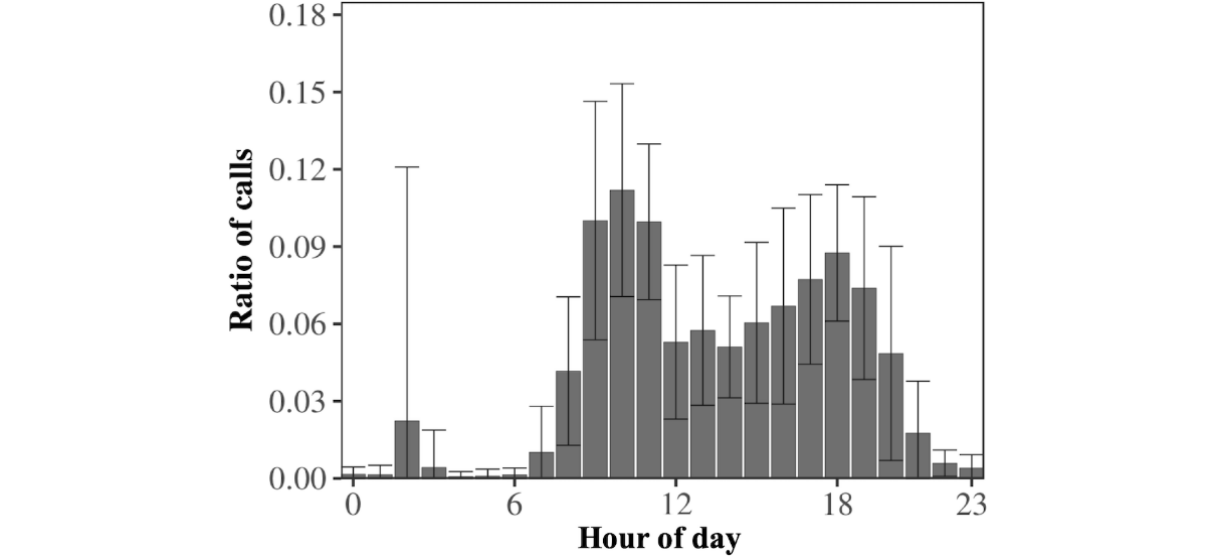
Figure 2. Aggregate-level circadian pattern of the outgoing telephone call activity of older adults. Bars represent the average hourly frequency of outgoing telephone calls. Error bars represent the hourly standard deviations. The wide range of the 5% error bars indicates that average outgoing telephone call activity differed significantly between individuals, especially at 2